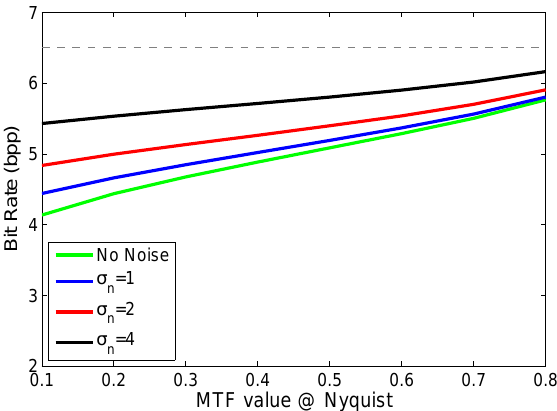
Figure 10. BR versus K min by varying σ n for the Yellowstone scene 0 in BIP format.